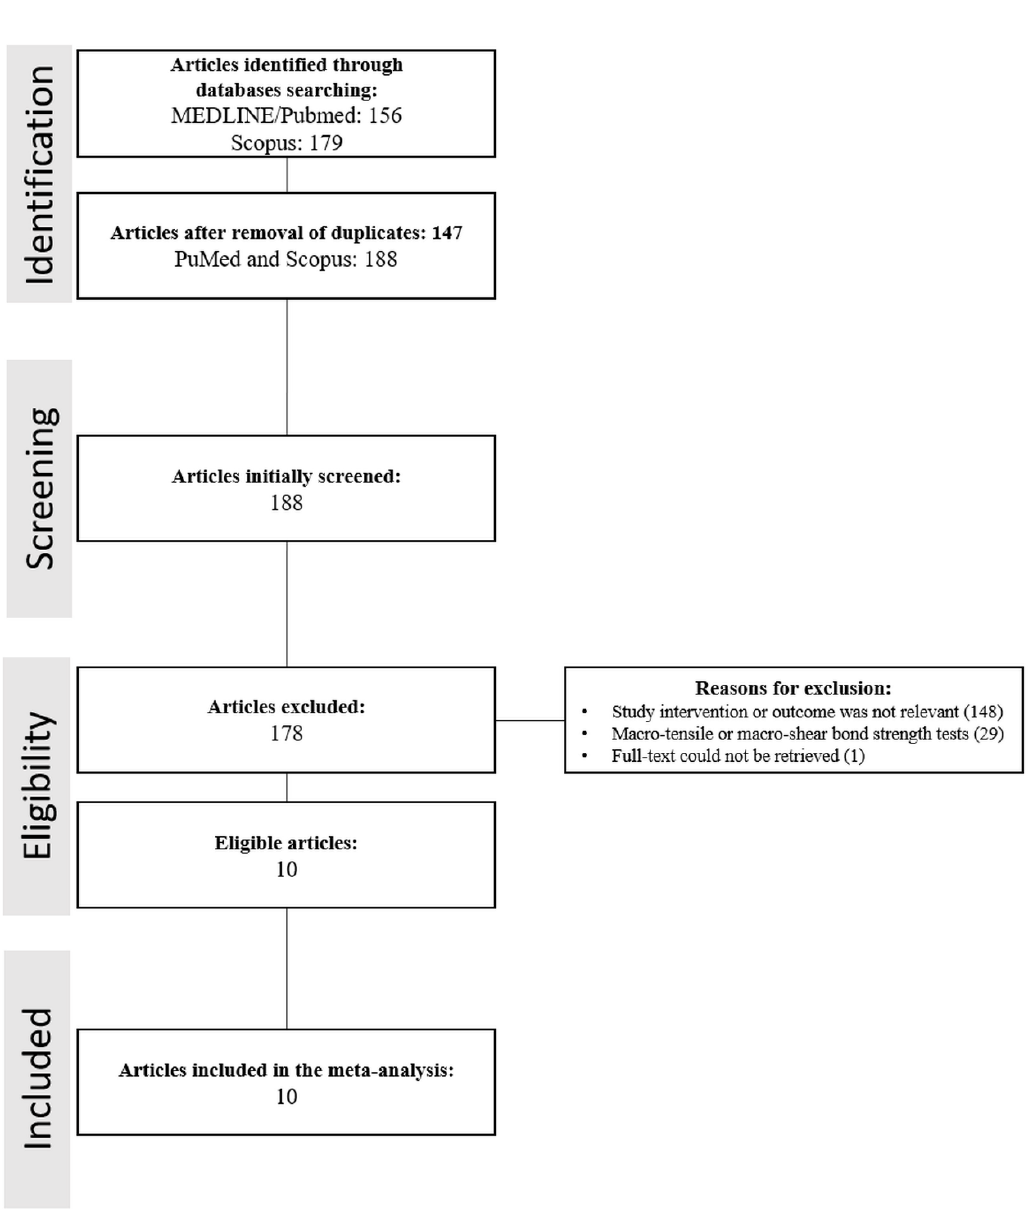
Figure 1. Systematic review flow chart of studies comparing the bond strength of adhesive systems / composite resin to coronal dentin after contact with eugenol-based materials and without contact.